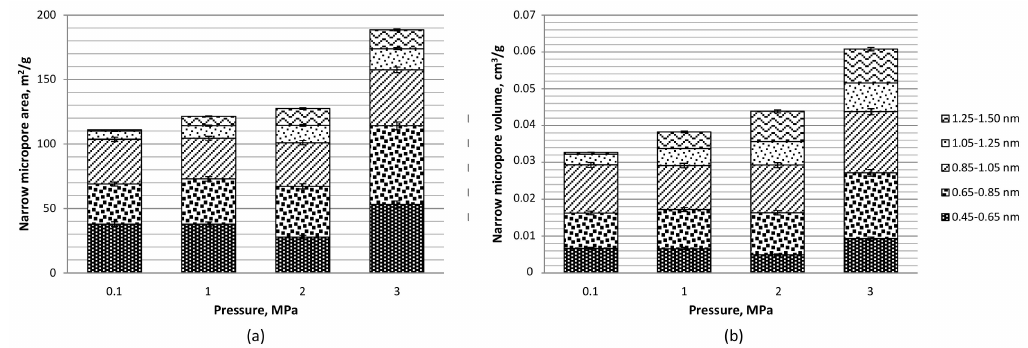
Figure 5. Narrow micropores: ( a ) area and ( b ) volume based on carbon dioxide isotherms at 0 ◦ C and Monte Carlo method for olive pomace-derived carbon materials produced at 800 ◦ C, under 0.1–3 MPa and with carbon dioxide